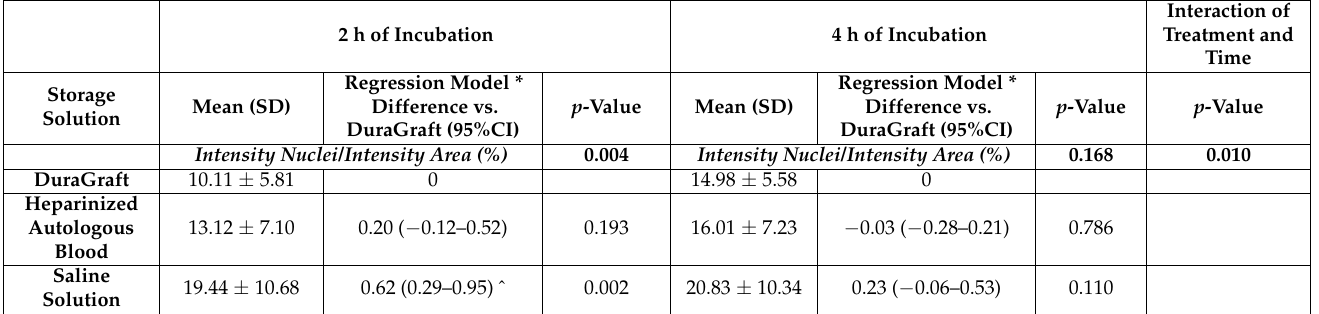
Table 1. Differences between treatment arms at 2 and 4 h (generalized linear regression model). Note: In- tensity nuclei/intensity area (percent) was log transformed * for model fitting. Given that the interaction of time and type of solution was present, we presented separate models after 2 and 4 h of incubation. 2 h of Incubation 4 h of Incubation